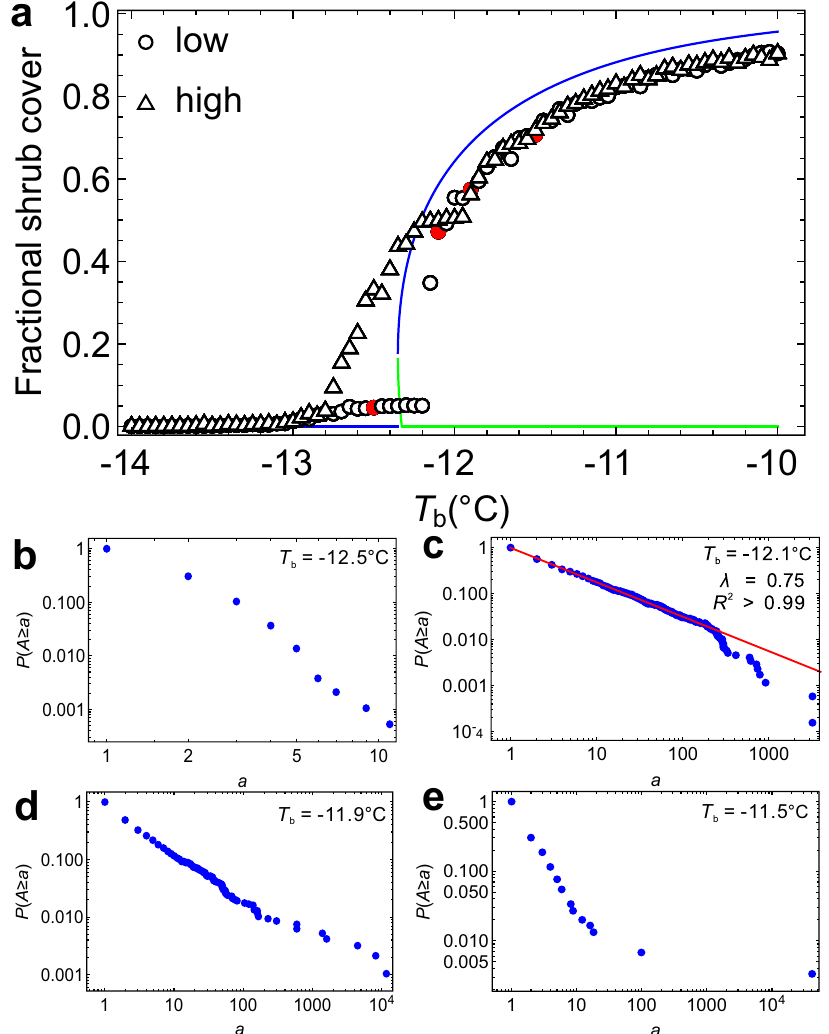
Fig. 4 The ecosystem stable states (indicated by shrub cover) under varying background minimum temperature ( T b ) conditions. We ran the model for both low initial shrub cover (0.05) and high initial shrub cover (0.5). a Bifurcation in the dynamics of woody vegetation on Hog Island. Both mean fi eld analysis (line) and simulation results from the full spatial model are shown. Stable and unstable states are indicated by blue and green lines, respectively. The size distributions of woody patches under four T b conditions are shown: − 12.5 °C ( b ), − 12.1 °C ( c ), − 11.9 °C ( d ), and − 11.5 °C ( e ). The size distribution follows a power law when T b is close to − 12.1